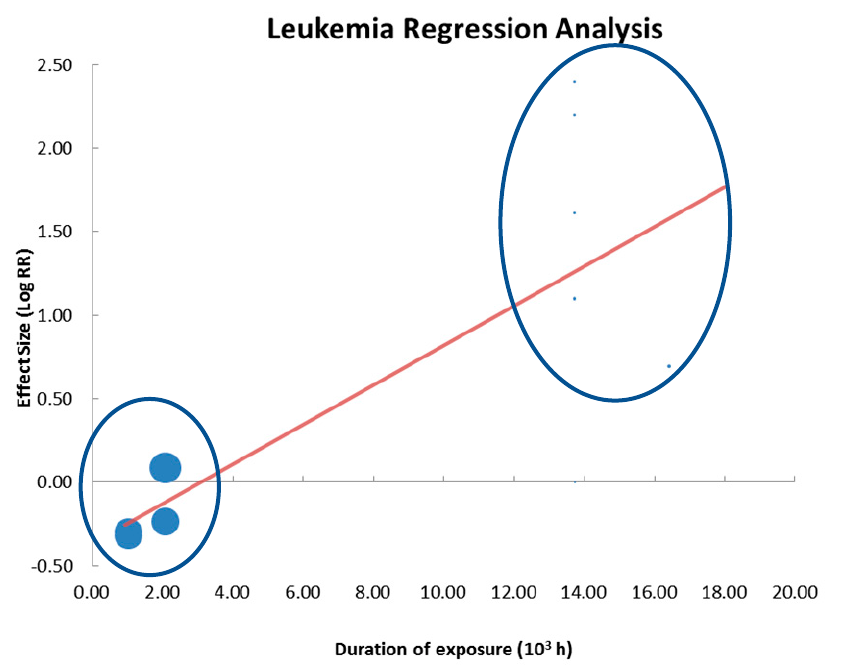
Figure 7. Regression analysis graph for the Leukemia sample.